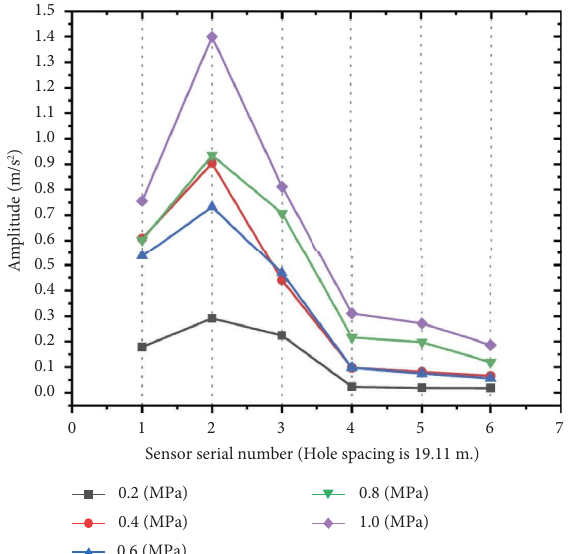
Figure 4: Variation of the amplitude of A and B leakage with the distance under diferent pressures.